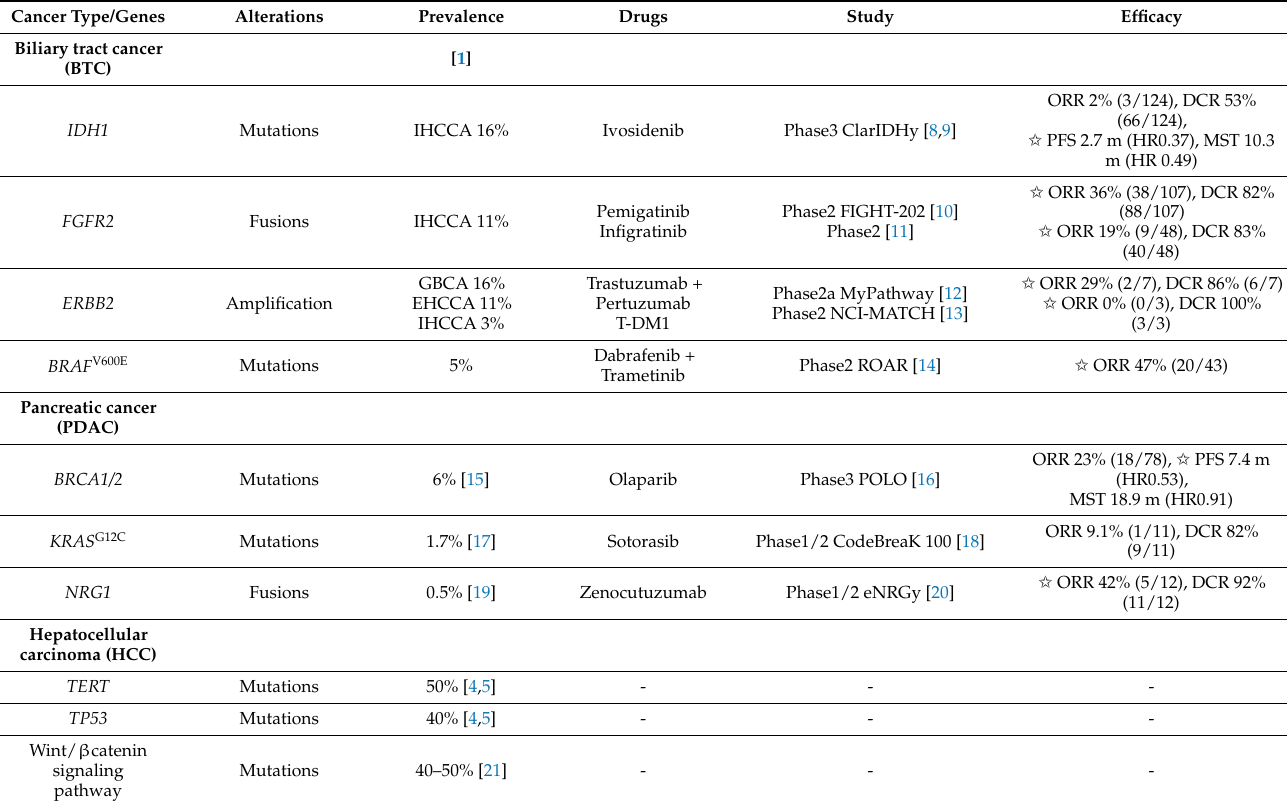
Table 1. Therapy-targeted gene alterations and clinical trial treatment results for hepatobiliary and pancreatic